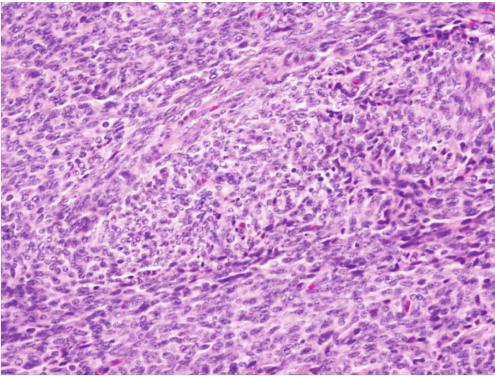
Figure 1: A representative hematoxylin and eosin stain of the colonicESS.Thetumoriscomprisedofroundtoovalplumpspindle- shaped nuclei with minimal nuclear atypia and rare mitotic features. Small, prominent arterioles are interspersed between the stromal